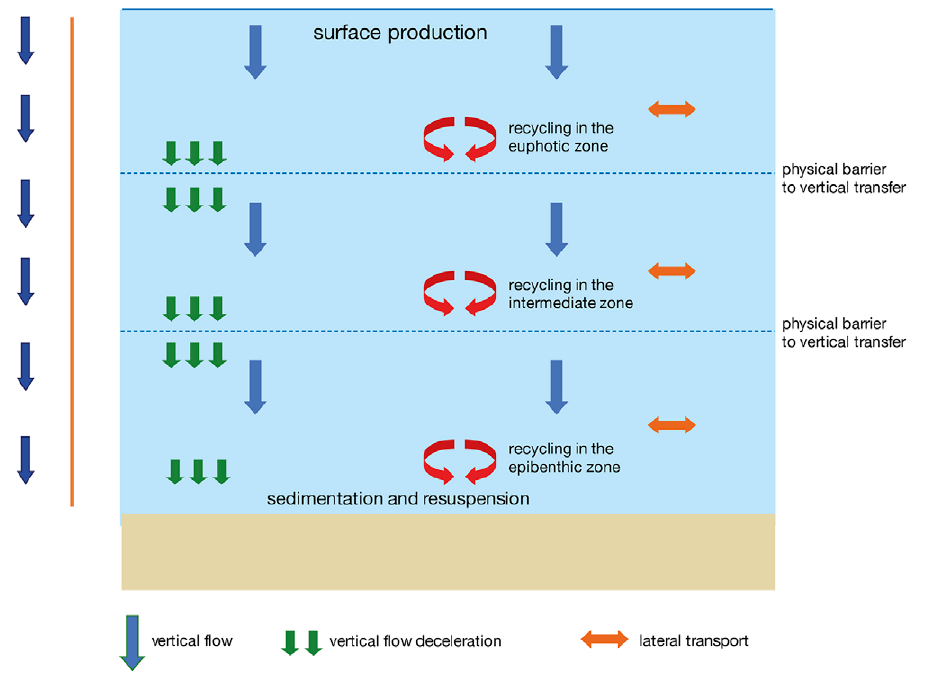
Fig. 4. – Schematic representation of the relationship between benthic communities and vertical fluxes along water column